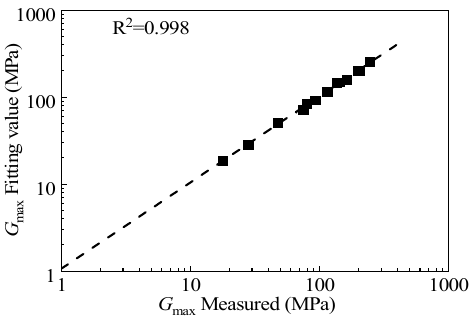
Figure 23. The relationship between the experimental value and fitting value of the maximum dynamic shear modulus.